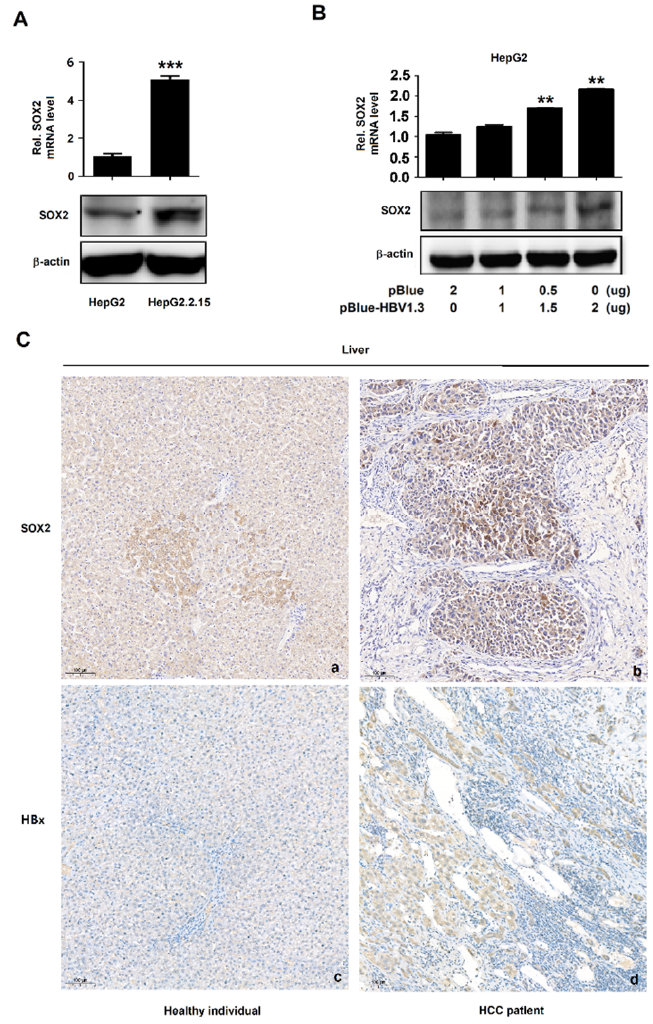
Figure 1. HBV induces sex determining region Y box2 (SOX2) expression. ( A ) The mRNA of SOX2 in HepG2 and HepG2.2.15 was determined by qRT-PCR (upper). GAPDH was used as the internal control. The protein of SOX2 in HepG2 and HepG2.2.15 were detected by Western blot (lower). β- actin was used as the internal control in Western blot. ( B ) HepG2 cells were plated in 6-well plates and transfected with pBlue or pBlue-HBV1.3 (genotype D). The cells were collected at 48 h post- transfection, and the mRNA and protein of SOX2 were detected by qRT-PCR (upper) and Western blot (lower). ( C ) Immunohistochemical staining of SOX2 and HBxAg (ab39716, abcam, Cambridge,